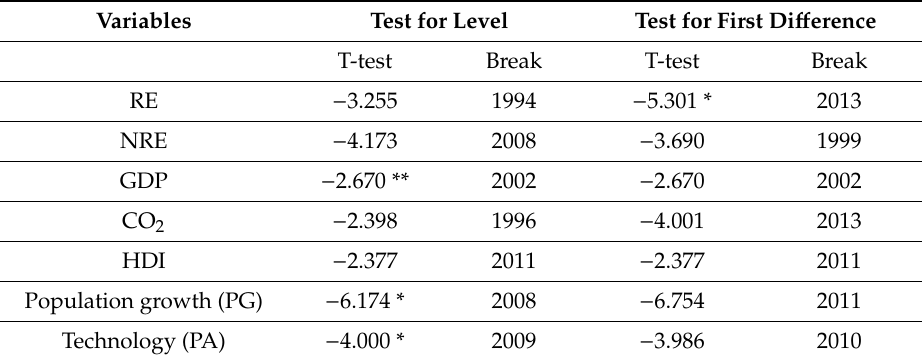
Table 1. The Zivot–Andrews unit root test for structural breaks. Variables Test for Level Test for First Di ff erence